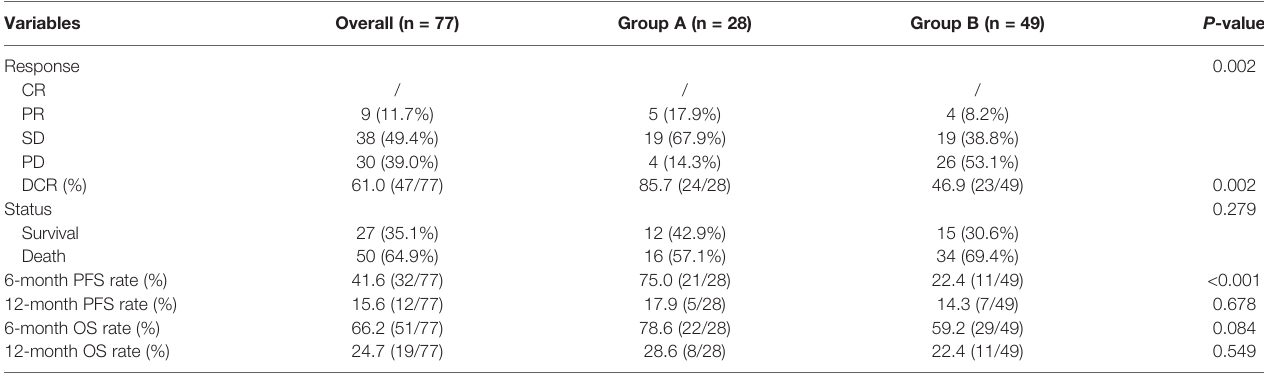
TABLE 4 | Clinical outcomes between ASTRI-NSCLC patients in groups A and B.